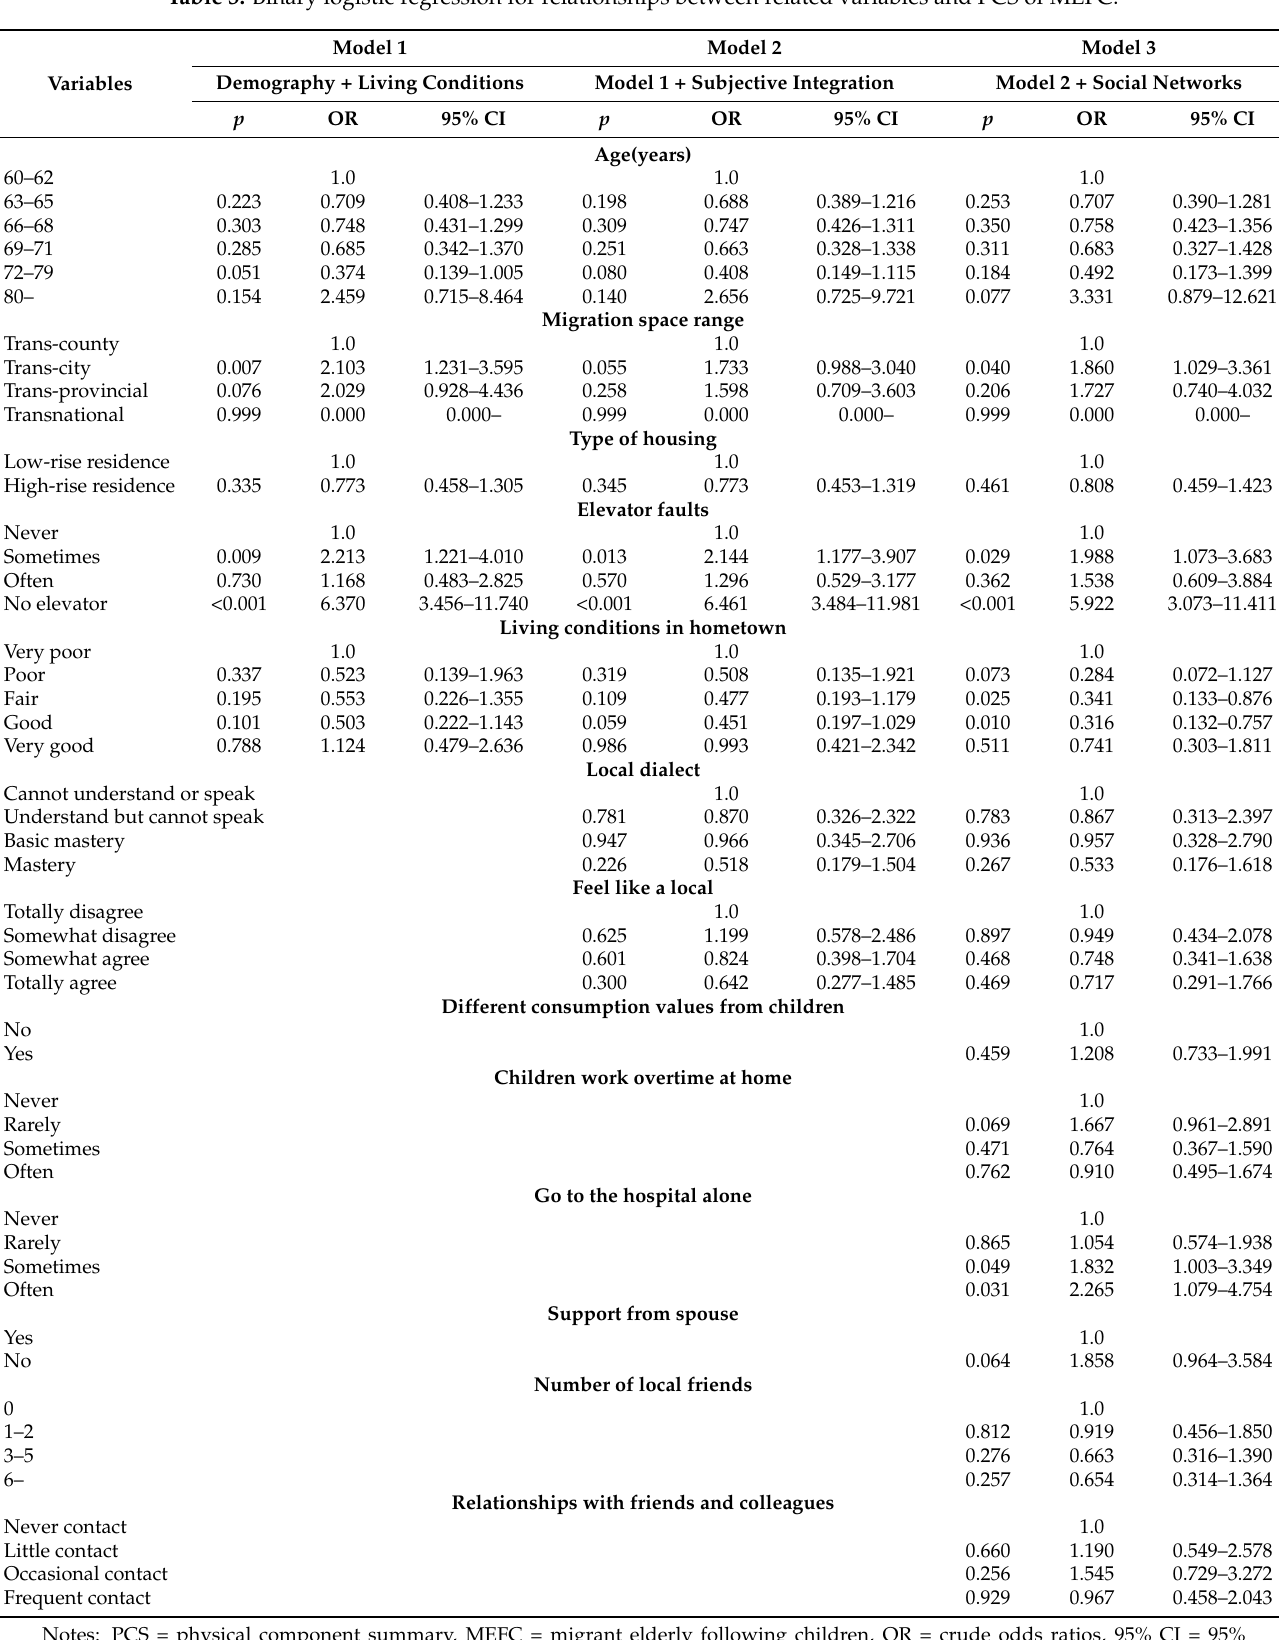
Table 3. Binary logistic regression for relationships between related variables and PCS of